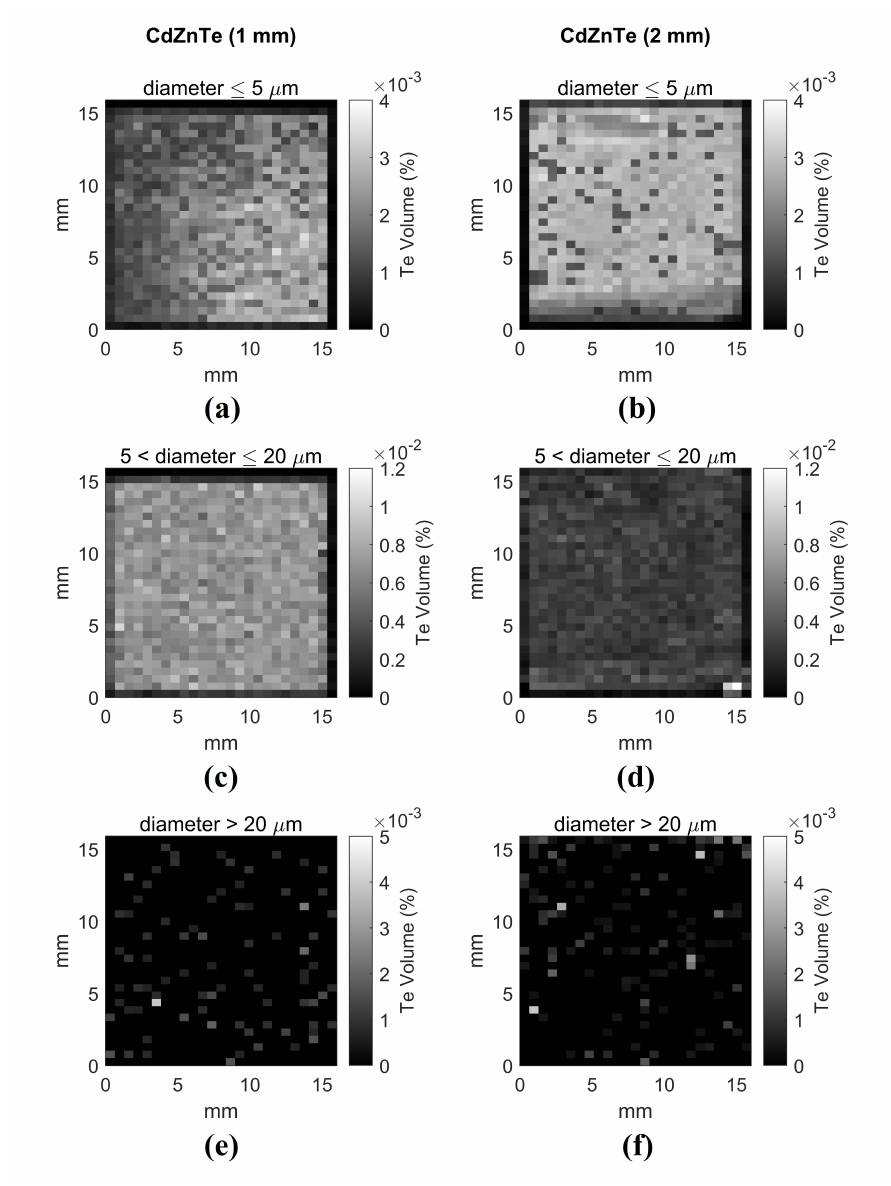
Figure 4. 2D histograms showing the fraction in percentage of the volume occupied by Te inclusions with diameter smaller than 5 µm ( a , b ), ranging from 5 to 20 ( c , d ) and greater than 20 ( e , f ) for the 1 mm-thick ( left ) and 2 mm-thick ( right ) detectors,